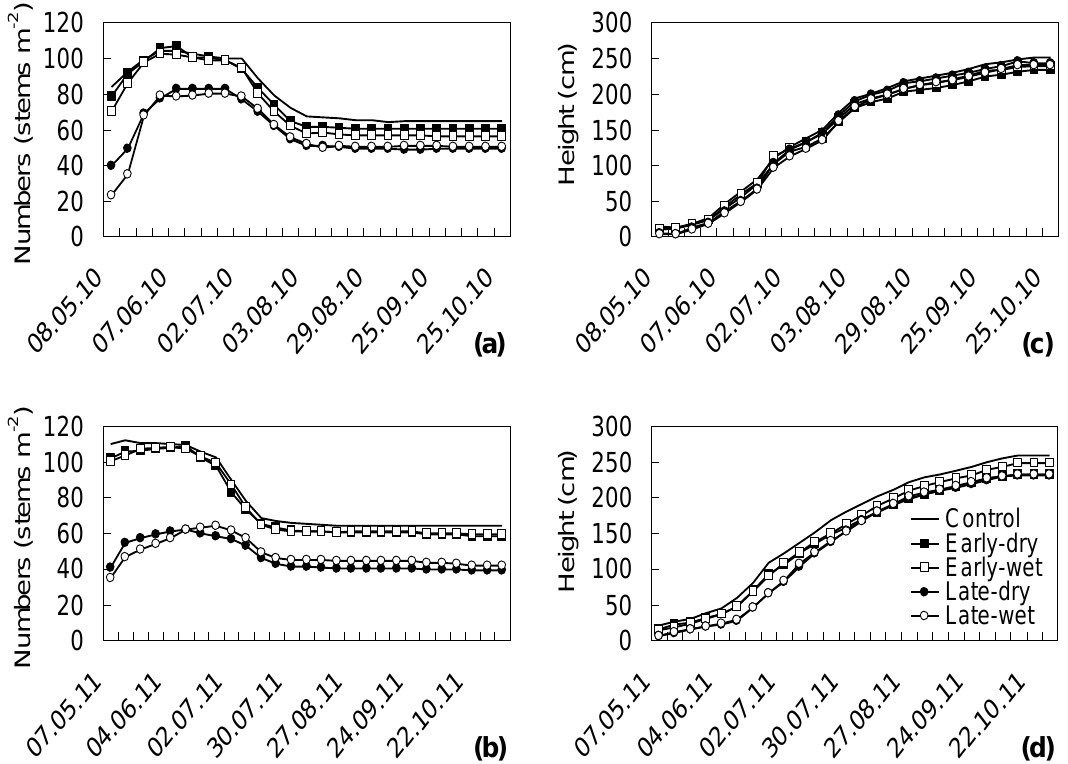
Figure 2. Weekly stem numbers (stems m − 2 ) and stem height (cm) in the growing seasons (April 1st to October 31st) 2010 ( a , c ) and 2011 ( b , d ).